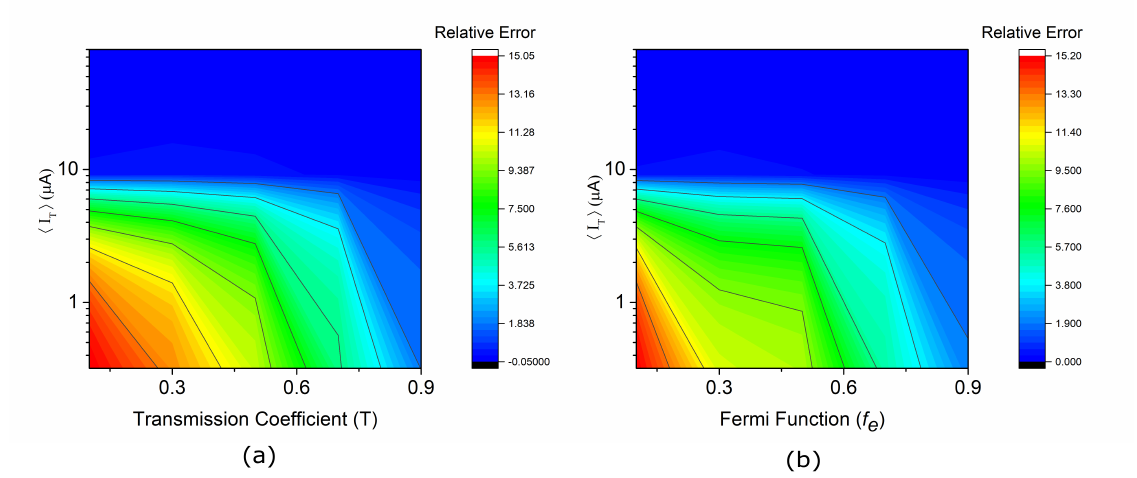
Figure 3. ( a ) Plot between the relative error, the transmission coefficient and the average current with the Fermi function fixed to unity. The relative error which is an indicator of quantum randomness, goes to zero, when the number of electrons in the device quantified by transmission coefficient and the mean current becomes very large (blue shaded region) while the relative probability of error is greater (in the red region) when the number of particles in the device is very small. In the green region the uncertainty already starts to disappear. ( b ) The same plot but with a constant transmission probability as unity and varying Fermi function also demonstrate the same